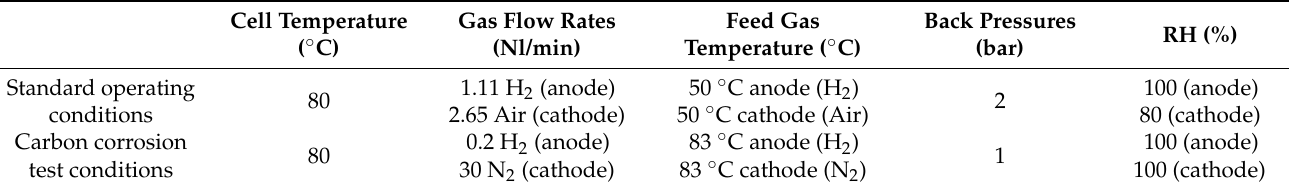
Table 2. Fuel cell operating conditions for the carbon corrosion AST.